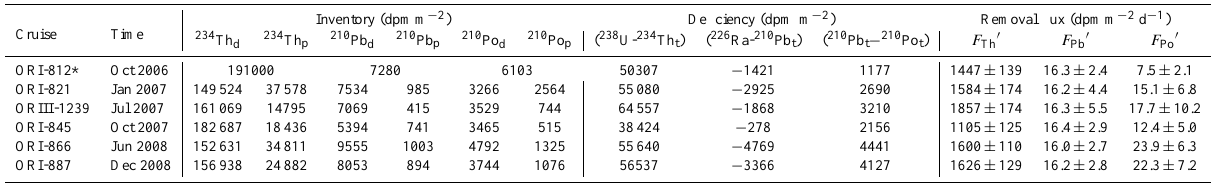
Table 2. Inventories of radionuclides in dissolved and particulate phases of seawater, deficiencies of total activity of daughter with respect to parent radionuclides, and their removal fluxes from the euphotic layer. Uncertainties of various removal fluxes are estimated based on propagated errors ( ± 1 σ)